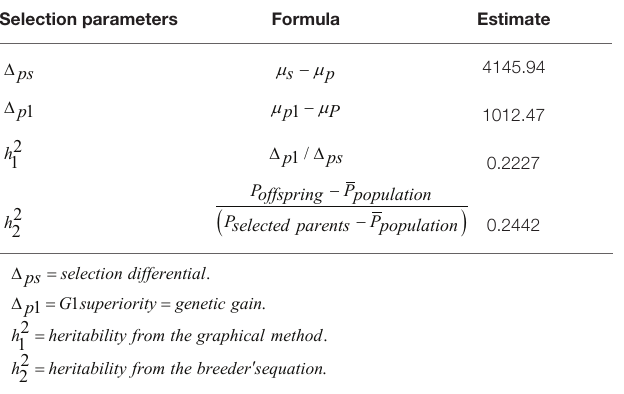
TABLE 3 | Selection parameters and heritability estimate from the direct method.